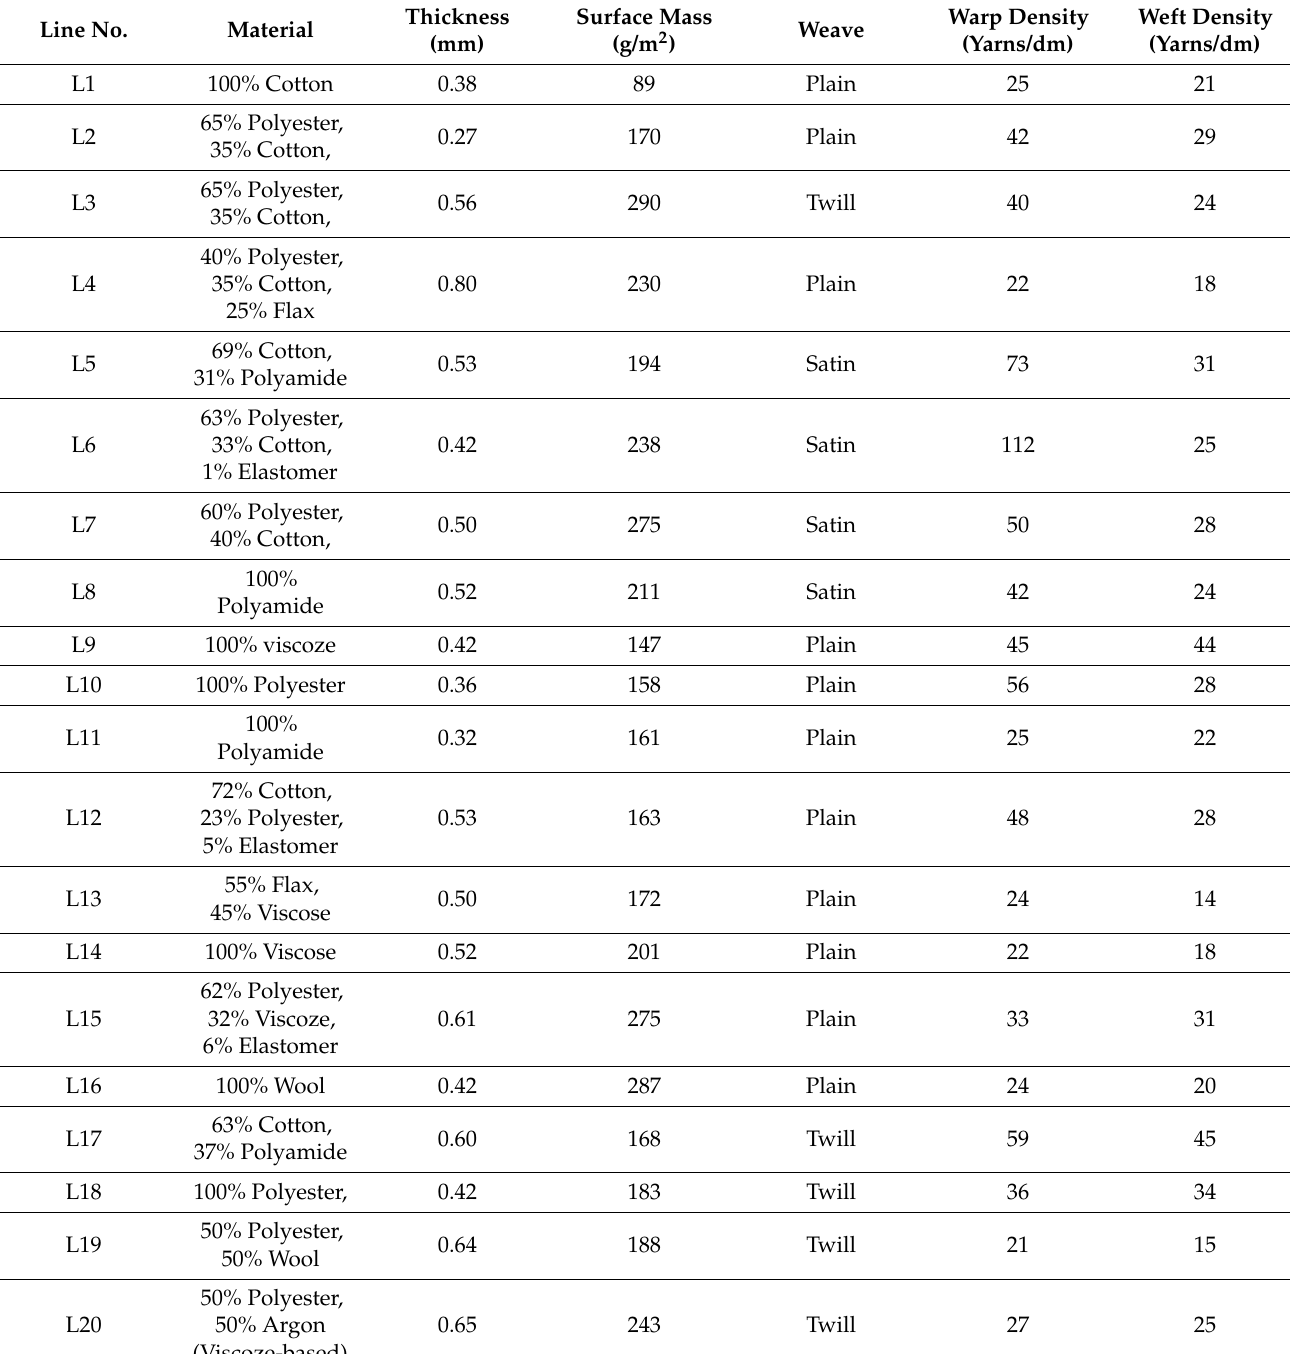
Table 2. The basic parameters of fabrics are used as a non-electroconductive substrate. Line